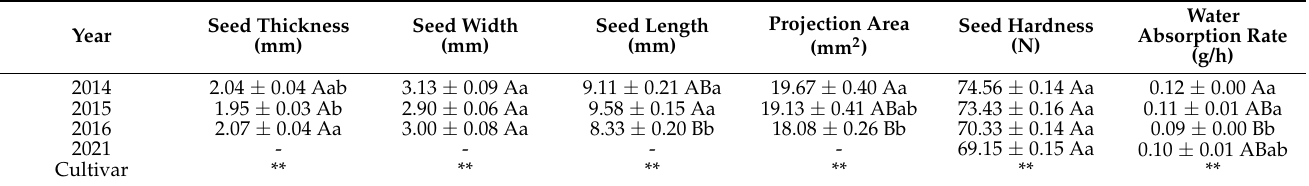
Table 2. MANOVA analysis of seed physical properties of different rice cultivars in different years.